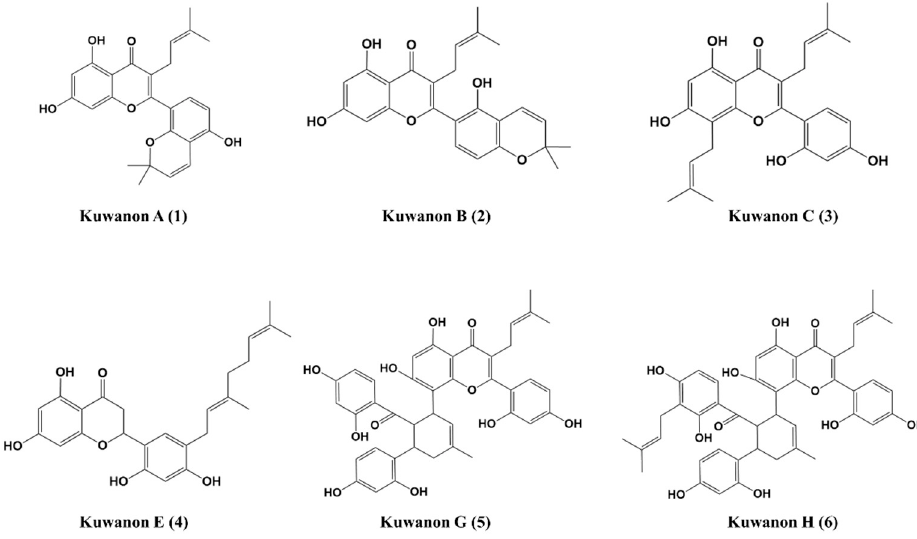
Figure 1. Chemical structures of the kuwanon derivatives isolated from the roots of Morus alba L. Table 1. Results of the in vitro COX-1/2 enzyme inhibition assay.